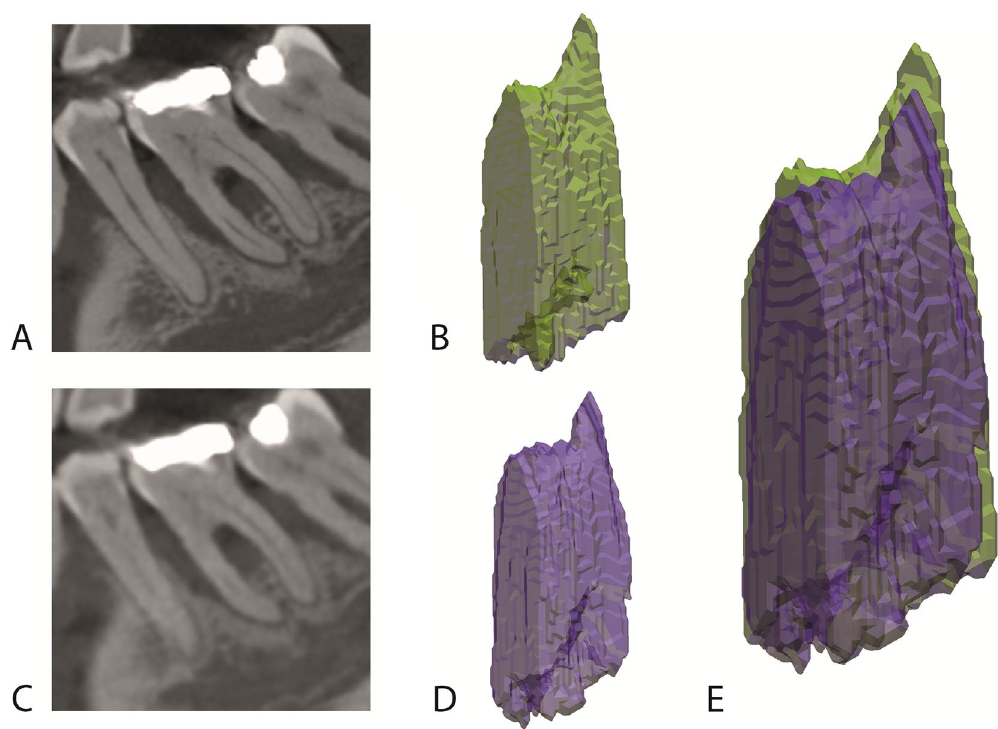
Figure 3. Volume segmentation of the furcation at tooth 36. ( A ) HD-CBCT of tooth 36 in the sagittal plane. ( B ) Corresponding volume model after segmentation and export as STL data into Geomagic Design X. ( C ) LD-CBCT of tooth 36 in the sagittal plane. ( D ) Corresponding volume model after segmentation and export as STL data into Geomagic Design X. ( E ) Overlay of the two STL data sets showing the high volume agreement between HD-CBCT and